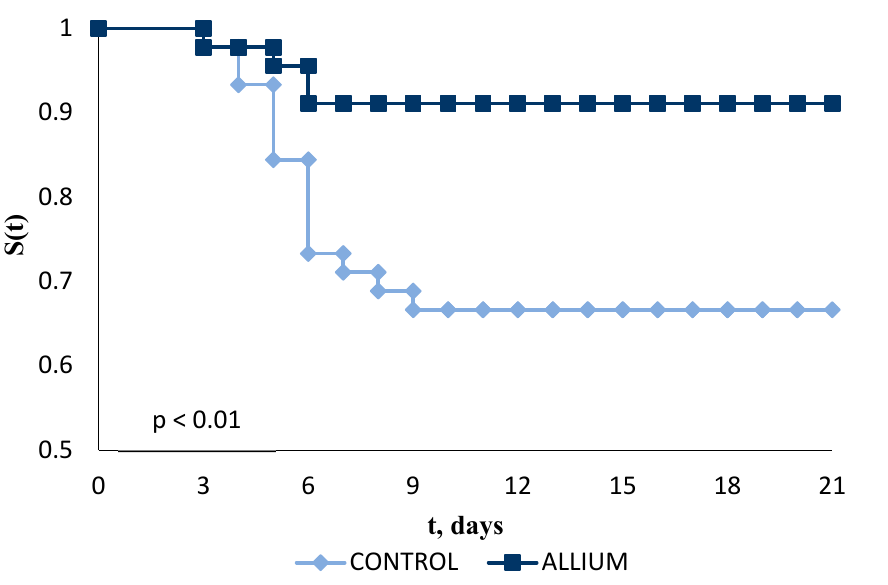
Figure 4. Kaplan–Meier Survival curves for seabream ( S. aurata ) fed a basal diet (control) or a diet supplemented with 150 mg/kg PTS/PTSO (ALLIUM) during 21 days of challenge test, compared to control using the long-rank test at a 95% confidence level.